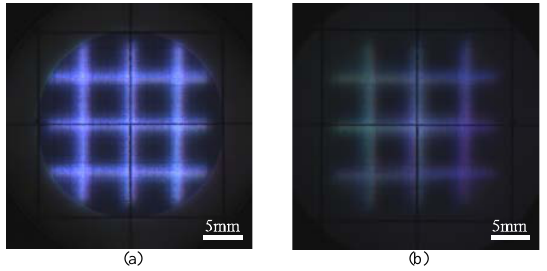
Figure 5. Electronic calibration of eight LFDs using grid patterns displayed by all LFDs on ( a ) CDP and ( b ) plane above CDP with a length of 14